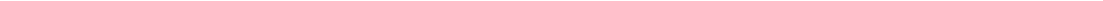
Fig. 6 Nfat proteins overcome cross-repression of Olig2 and Nkx2.2 in cooperation with Sox10. a TetSox10 , Brn4::Cre and Rosa26 stop fl ox-tTA alleles for CNS overexpression of Sox10. Arrows mark transcription start sites, triangles loxP sites. 9mycSox10, myc-tagged Sox10 coding sequences; bGI β -globin intron, Brn4p Brn4 promoter, Cre Cre coding sequences, EGFP enhanced GFP coding sequences, neo neomycin resistance cassette, pA polyadenylation site, PGK phosphoglycerate kinase promoter, SA splice acceptor, tetO bidirectional tetracycline-responsive promoter, tTA tetracycline-controlled transactivator coding sequences. b Immunohistochemistry for Sox10, Olig2, and Nkx2.2 on transverse spinal cord sections of wildtype (wt) and Sox10 overexpressing ( TetSox10 Brn4 ) embryos at 12.5 dpc. Right panels are magni fi cations of boxed areas with Olig2 in green and Nkx2.2 in red. Scale bars, 50 µ m. c N2a cell transfections with ECR19 luciferase reporter in absence ( − ) or presence ( + ) of Sox10, constitutively active CnA (CnA ca ) and Olig2 ( n = 3). Fold inductions ± SEM were determined after 48 h with reporter activity in the absence of effectors set to 1 (values: 13.1 ± 1.4 for Sox10, 0.9 ± 0.2 for Olig2, 1.8 ± 0.5 for CnA ca , 6.0 ± 0.5 for Sox10 and Olig2, 13.9 ± 2.4 for Sox10, Olig2 and CnA ca , and 42.9 ± 7.9 for Sox10 and CnA ca ). d N2a cell transfections with Olig2 OLEa luciferase reporter in absence ( − ) or presence ( + ) of Sox10 and Nfatc2 ( n = 3) (14.6 ± 1.7 for Sox10, 0.7 ± 0.0 for Nfatc2 and 14.9 ± 2.0 for Sox10 and Nfatc2) or ( e ) in absence ( − ) or presence ( + ) of Sox10, CnA ca and Nkx2.2 ( n = 3) (values: 19.0 ± 2.3 for Sox10, 1.8 ± 0.1 for Nkx2.2, 1.0 ± 0.1 for CnA ca , 7.3 ± 0.3 for Sox10 and Nkx2.2, 16.9 ± 0.6 for Sox10, Nkx2.2 and CnA ca , and 23.1 ± 3.3 for Sox10 and CnA ca ). f Neural tube electroporations in HH11-stage chicken embryos ( n = 3) and quanti fi cation of the relative number of electroporated cells, in which joint expression of Nkx2.2 and Olig2 was induced after 48 h (values: 0 for control, 8.4 ± 3.5 for Sox10, 11.5 ± 2.0 for Nfatc2, and 20.9± 5.4 for Sox10 and Nfatc2). g Immunohistochemical determination of the percentage of Mbp-expressing rat oligodendroglia transduced with GFP-expressing control ( − ) or Nkx2.2-overexpressing retrovirus ( + ), after 6 days of differentiation in absence (Ctr, open bars) or presence of 1 µ M FK506 (grey bars) ( n = 3 separate cultures). (Values: 84.0 ± 3.6% in GFP-transduced untreated cultures; 89.0 ± 1.7% in Nkx2.2-transduced untreated cultures; 53.7 ± 13.7% in GFP-transduced FK506-treated cultures; 84.1 ± 11.7% in Nkx2.2- transduced FK506-treated cultures). Statistical signi fi cance was determined by two-tailed Student ’ s t -test ( c – f ) and Bonferroni-corrected one-way ANOVA ( g ) (* P ≤ 0.05; ** P ≤ 0.01; *** P ≤